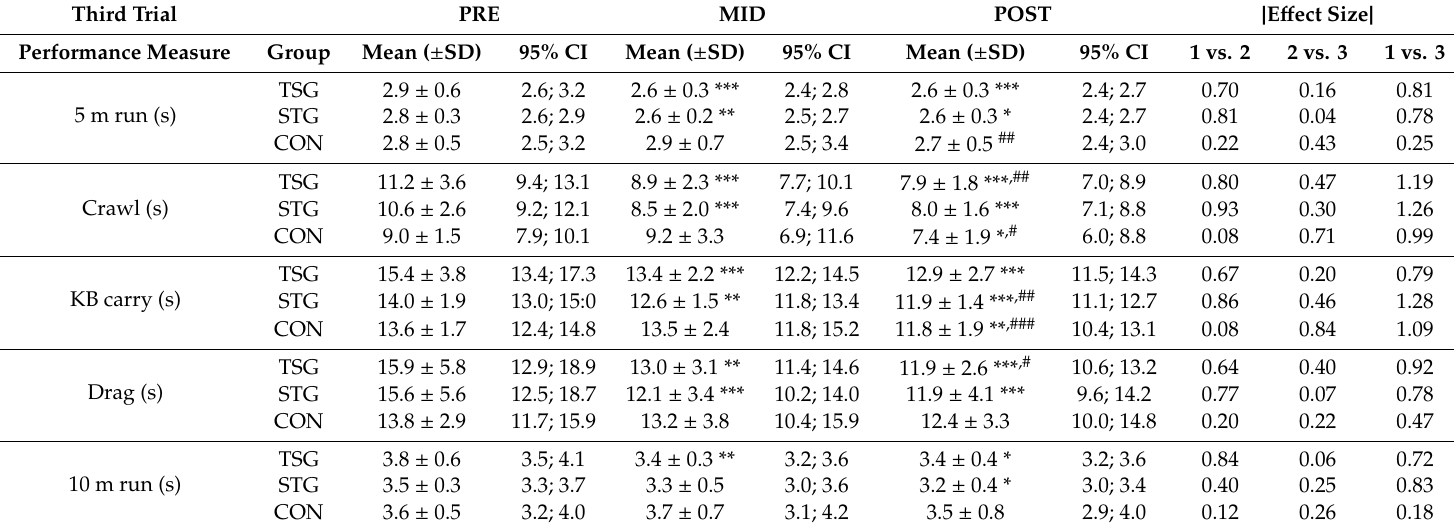
Table 5. Simulated military task performance times for di ff erent tasks (first 5 m run, crawl, kettlebell carry (KB), casualty drag, and final 10 m run) from the third trial in the PRE, MID, and POST measurement